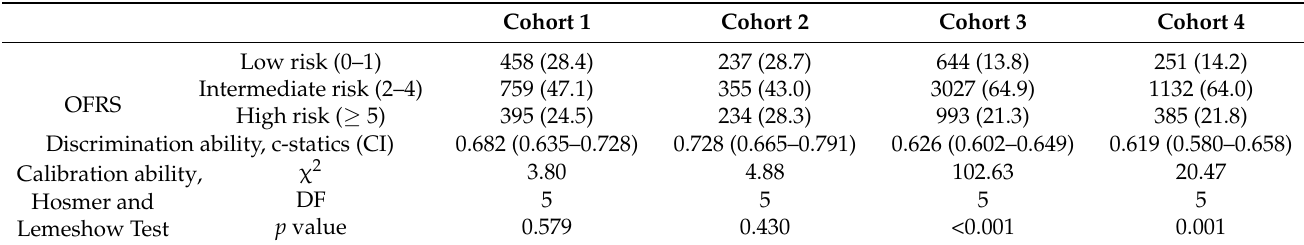
Table 3. Characteristics and prediction performance of OFRS for 90-day mortality in each